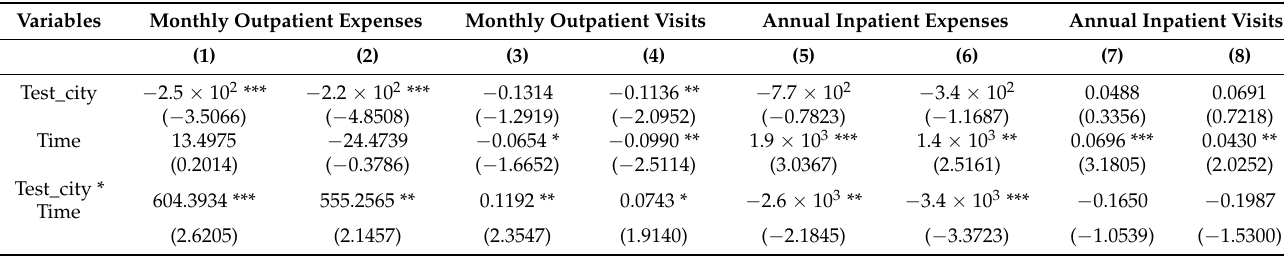
Table 6. PSM-DID results of urban